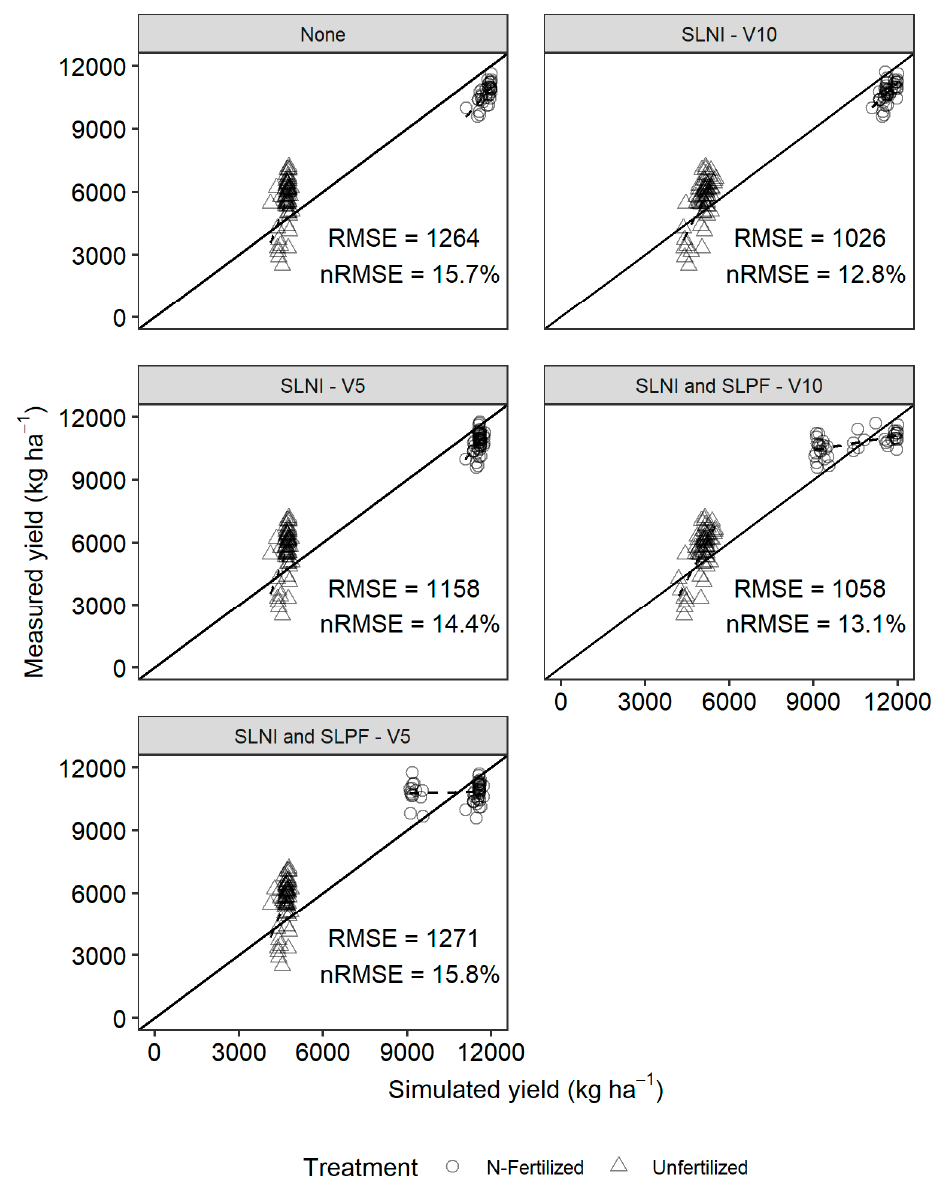
Figure 7. Scatterplots of simulated and measured maize yield. The diagonal black line is the 1:1 line. The dashed black line represents the linear regression between simulated and measured yields.